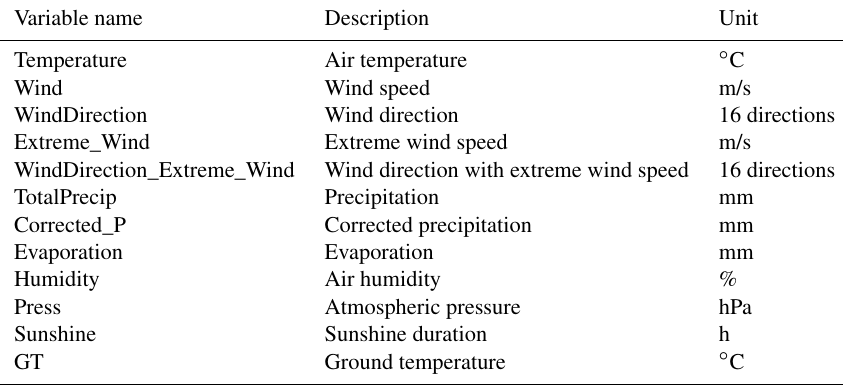
Table F1. Overview of the meteorological and ground observation data. The suffixes _MIN, _MAX, _AVG, and _QC indicate the minimum, maximum, average value, and quality control code of the variable, respectively, while 32766, NA, and NAN indicate null values. The suffix of TotalPrecip with “20_8”, “8_20”, and “20_20” are the total precipitation from 20:00 to 08:00UTC/GMT + 8 the next day, 08:00 to 20:00, and 20:00 to 20:00 the next day, respectively. The suffixes of evaporation with “SmallEvaporators” and “LargeEvaporators” are the data monitored by the small and large evaporator, respectively. The suffix GT with a number indicates the ground temperature in centimetres.